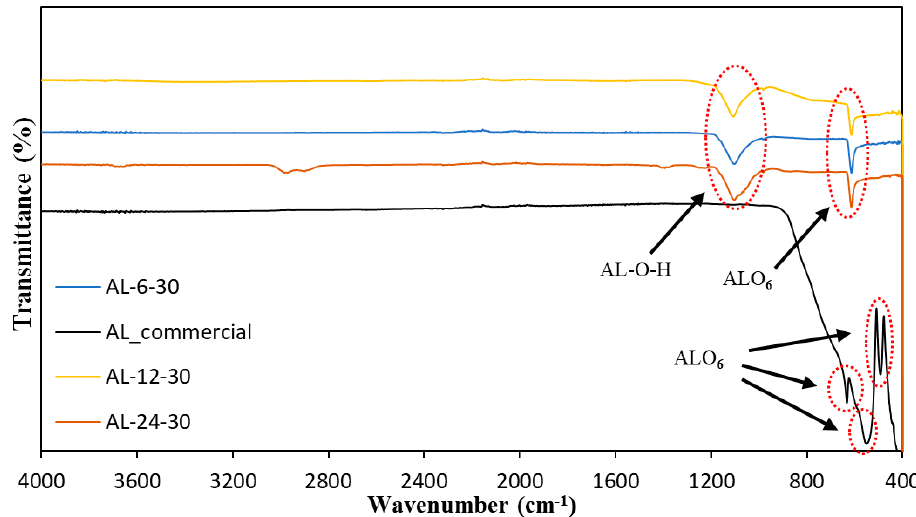
Figure 1. FTIR spectra comparing the effect of reaction times on synthesis of Alumina; AL-6-30, AL-12-30, AL-24-30 and AL-Commercial.